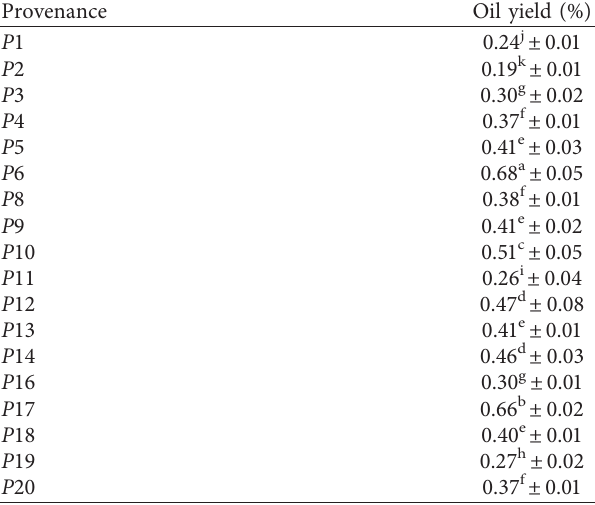
Means with different letters in the same column were significantly different at p < 0 . 05. Results are expressed as mean ± standard deviation of 3